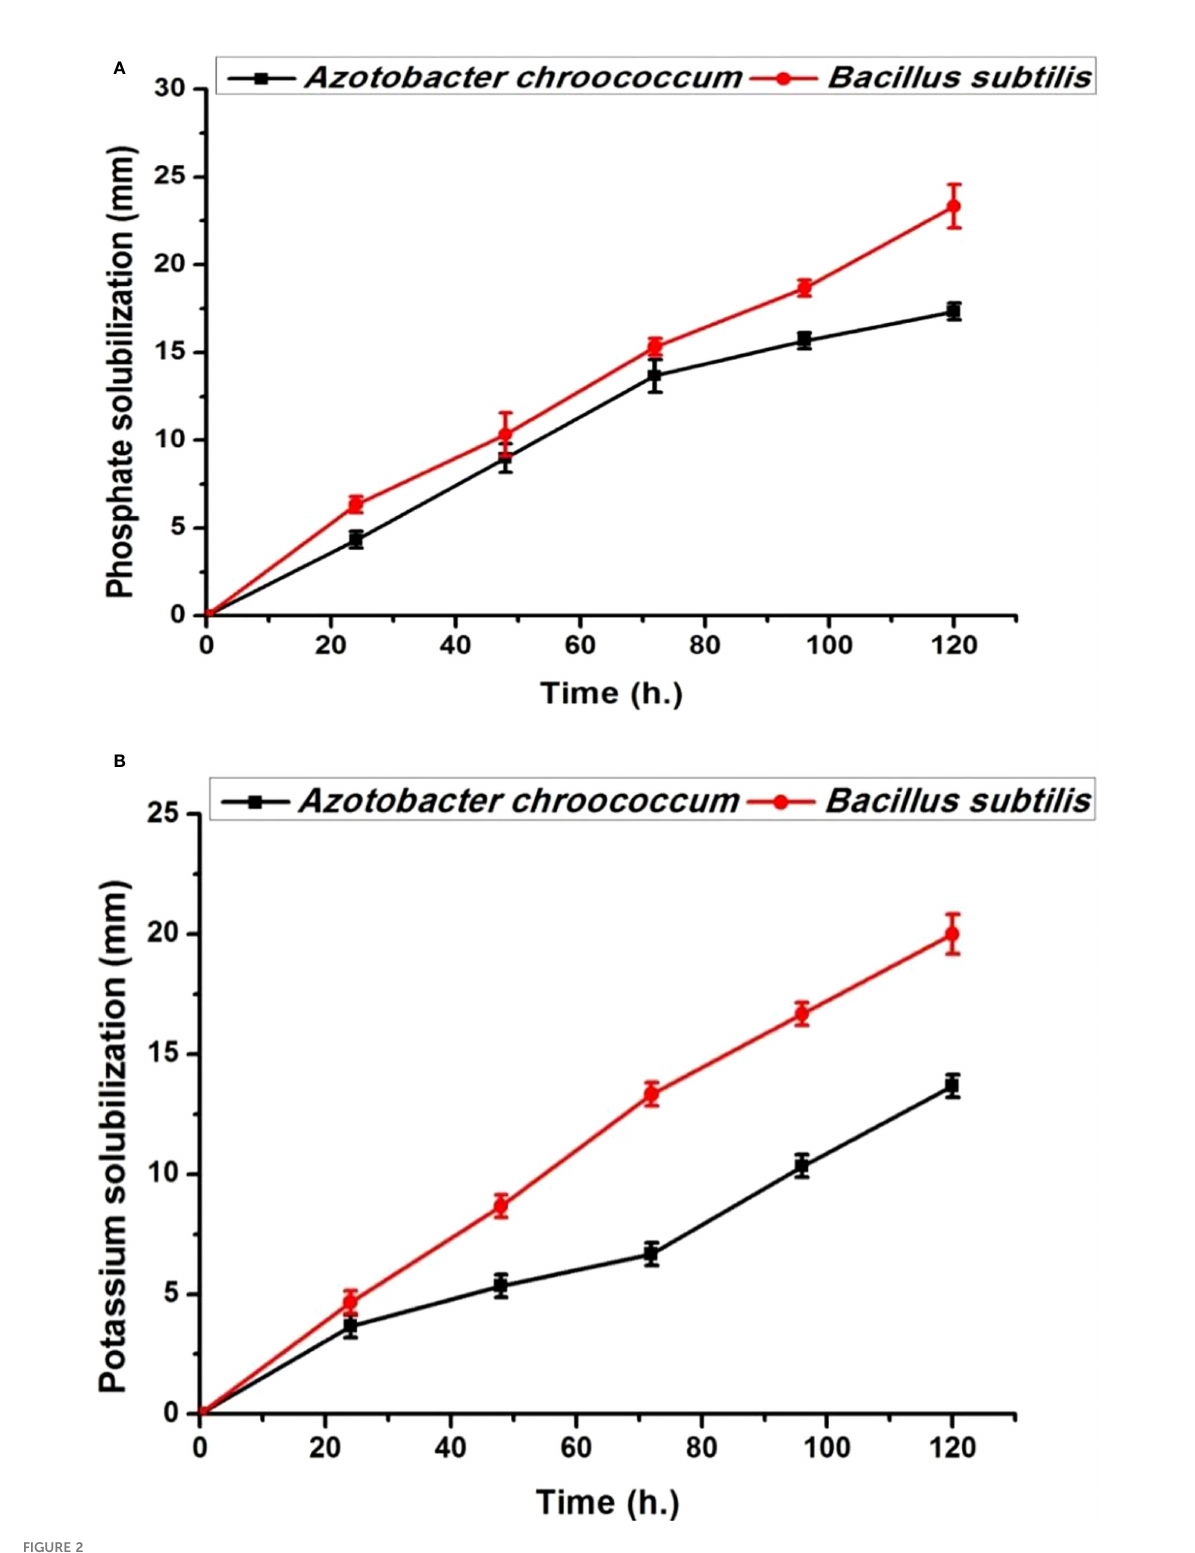
FIGURE 2 Phosphate solubilization time course as growth diameter (mm) on Pikovskaya ’ s agar (A) and K solubilization on Aleksandrov ’ s agar (B) mediums by the plant growth-promoting (PGP bacteria) Azotobacter chroococcum and Bacillus subtilis